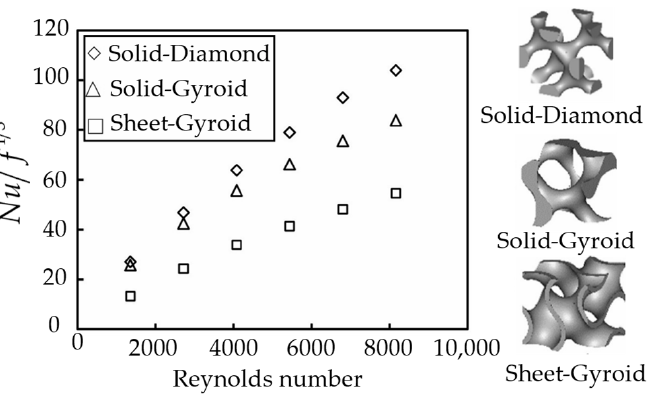
Figure 7. Thermal performance of cooling channels for different TPMS topologies at the same porosity [48].